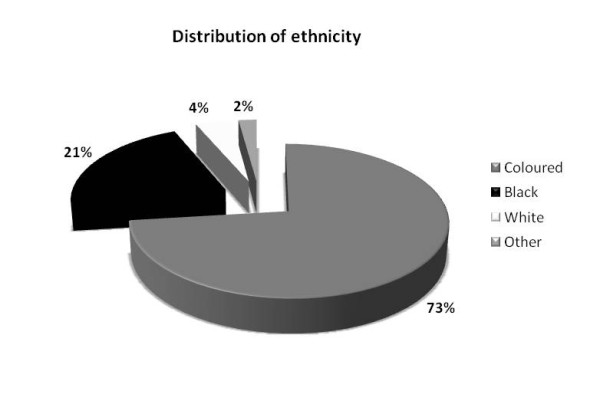
Distribution of ethnicity per language group.